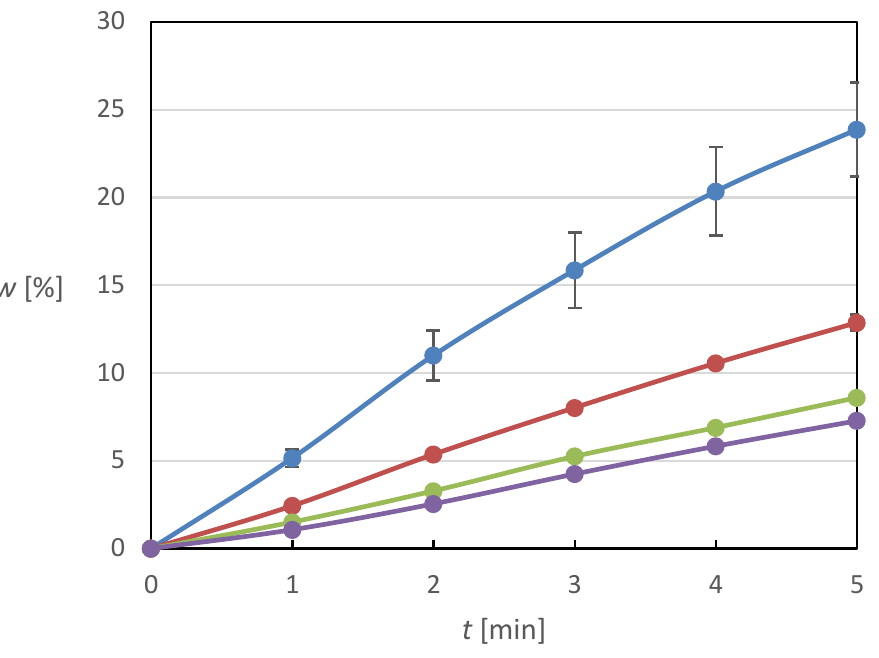
Figure 3. Dissolution profiles of tablets prepared by applying an 8 mg/mL MX THF solution, including error bars (5 drops ■ , 10 drops ■ , 15 drops ■ , 20 drops ■ ); the curves are the connecting points of each data series.